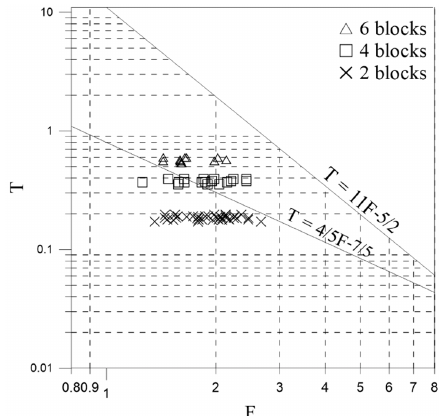
Figure 11. Plot of the wave type product T versus the Froude number F for the 3D tests conducted in the present study. All waves observed were Stokes-like. The boundaries provided are from Heller and Hager [27] observed for the 2D case using granular slides.